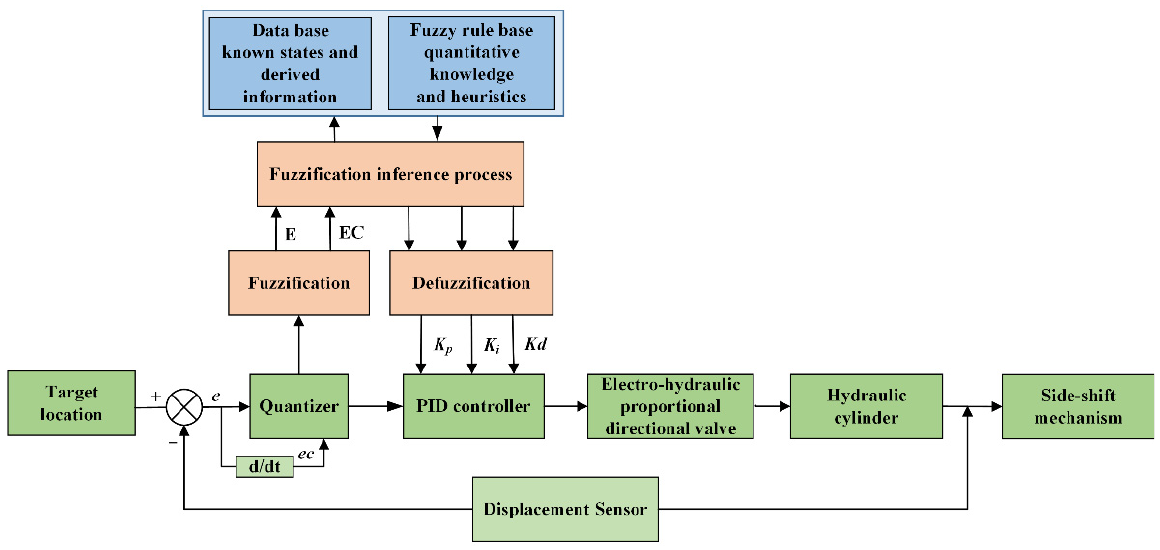
Figure 7. Fuzzy PID structure of control system.